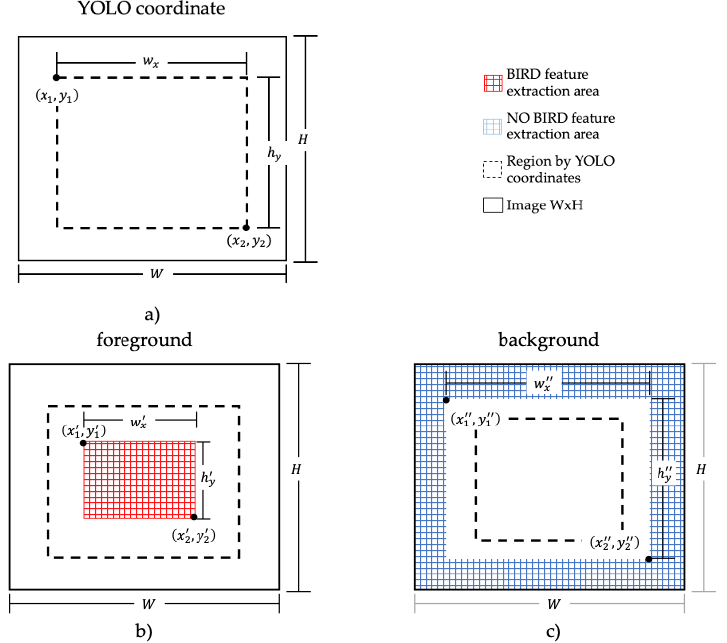
Figure 7. The region selected as bird and non-bird: ( a ) YOLOV3 coordinates; ( b ) the provisional region as a bird; and ( c ) the provisional region as non-bird. Configuration 2: pre-segmentation coordinates are increased by 20%. Pixels outside Configuration 2 are classified as non-birds, Figure 7c. The coordinates of Configuration 1 are described below.